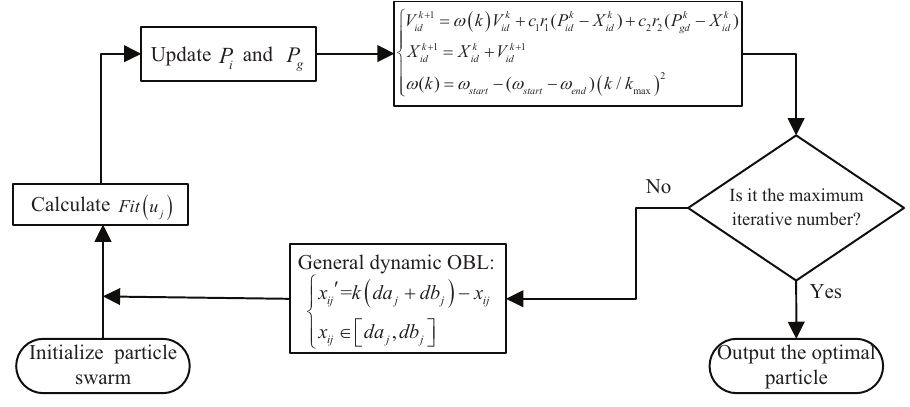
Figure 8. The flow chart of improved particle swarm optimization